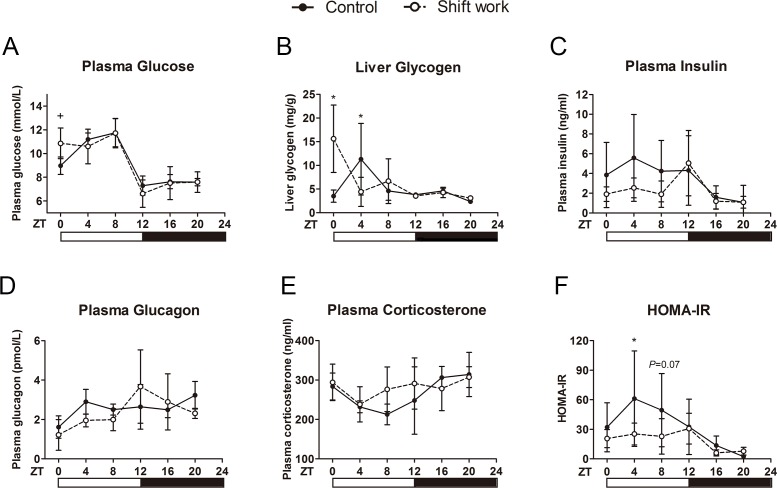
The effect of shift work on blood biochemistry, liver glycogen and HOMA-IR.(A) Plasma glucose, and (B) liver glycogen and plasma (C) insulin, (D) glucagon, (E) corticosterone, (F) homeostasis model assessment of insulin resistance index (HOMA-IR) were detected across a 24-h cycle in control and shift work mice. N = 4–5/time point/group, except glucose and HOMA-IR in the control group at ZT20 (n = 3). The data are mean ± SD. *P<0.05, Two-way ANOVA and Bonferroni post hoc test; +P<0.05, Student’s t test.